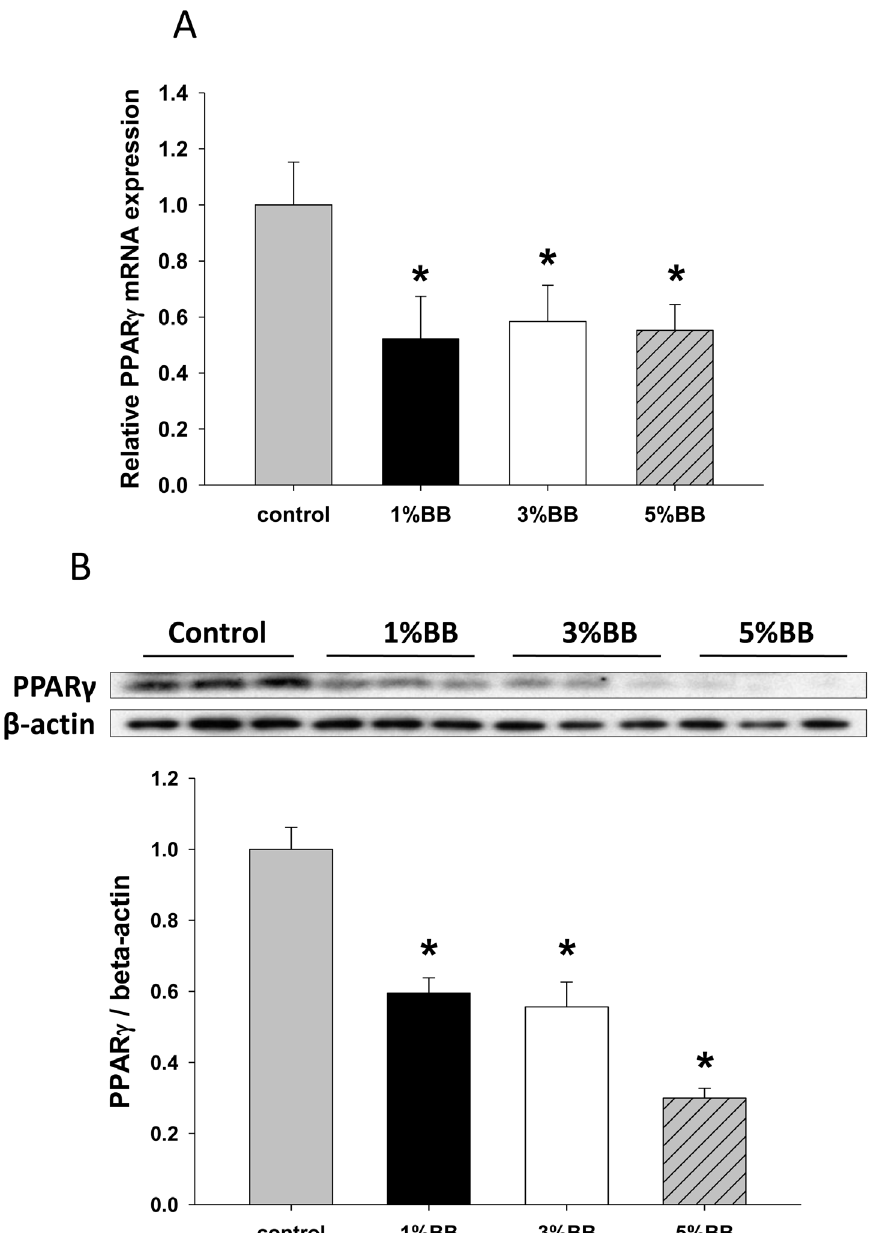
Figure 4. BB diet down-regulates PPAR c expression in bone. (A) Real-time PCR shows PPAR c gene expression in bone from four different diet rat groups. (B) Western blot shows PPAR c protein expression in bone from four different diet rat groups. Bar graph under the blots is quantitative data of relative PPAR c intensity to b -actin of bands from western blots. For western blots, 3 to 4 animal samples were randomly pooled to one for a total of three samples per group on western blot. Data are means 6 SEM. n=10 animals/group. *, p , 0.05 versus control.